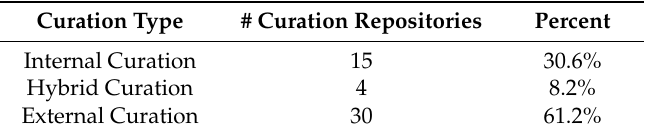
Table 3. Sources of the curation repositories.